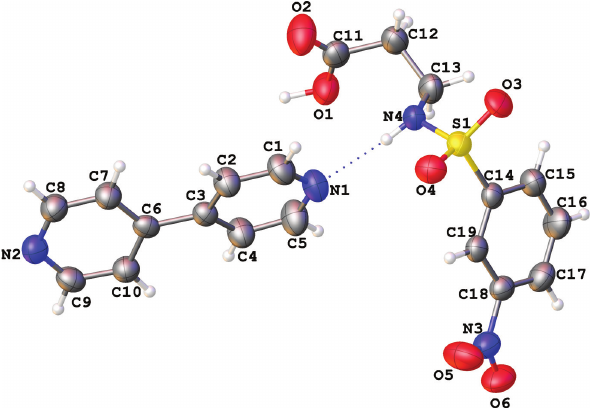
Table 2: Fractional atomic coordinates and isotropic or equivalent isotropic displacement parameters (Å 2